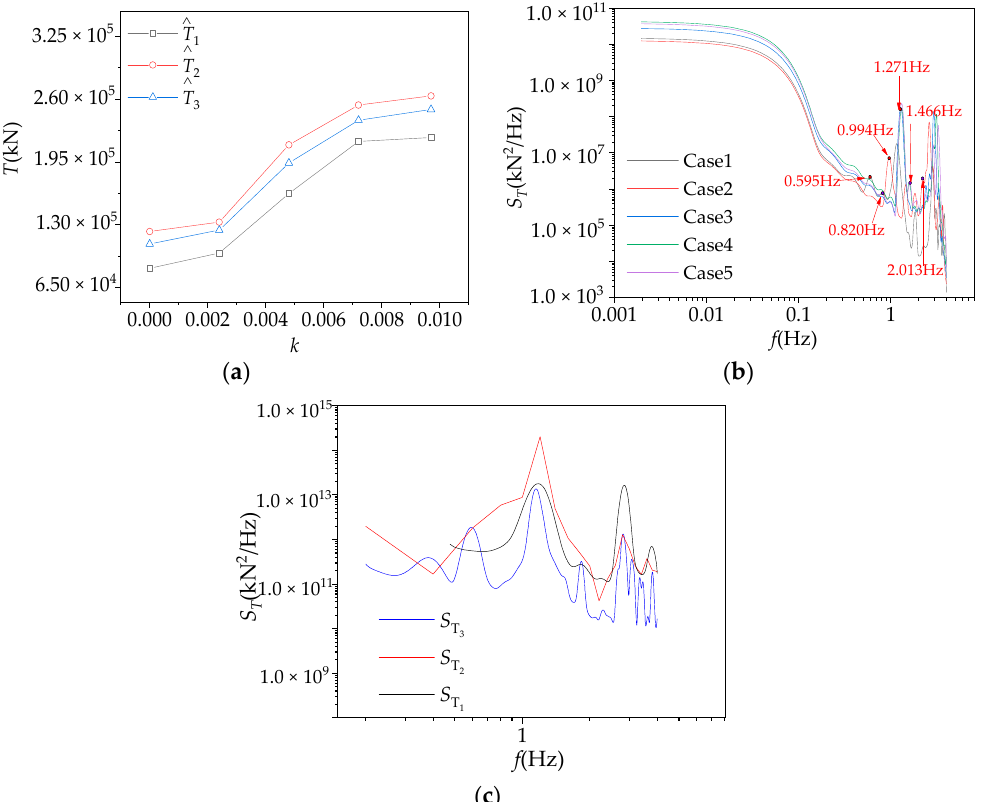
Figure 4. Cable tension response analysis with a curvature transform: ( a ) peak tension; ( b ) tension spectrum; and ( c ) cable tension spectrum analysis of case 5 throughout the cable breakage.